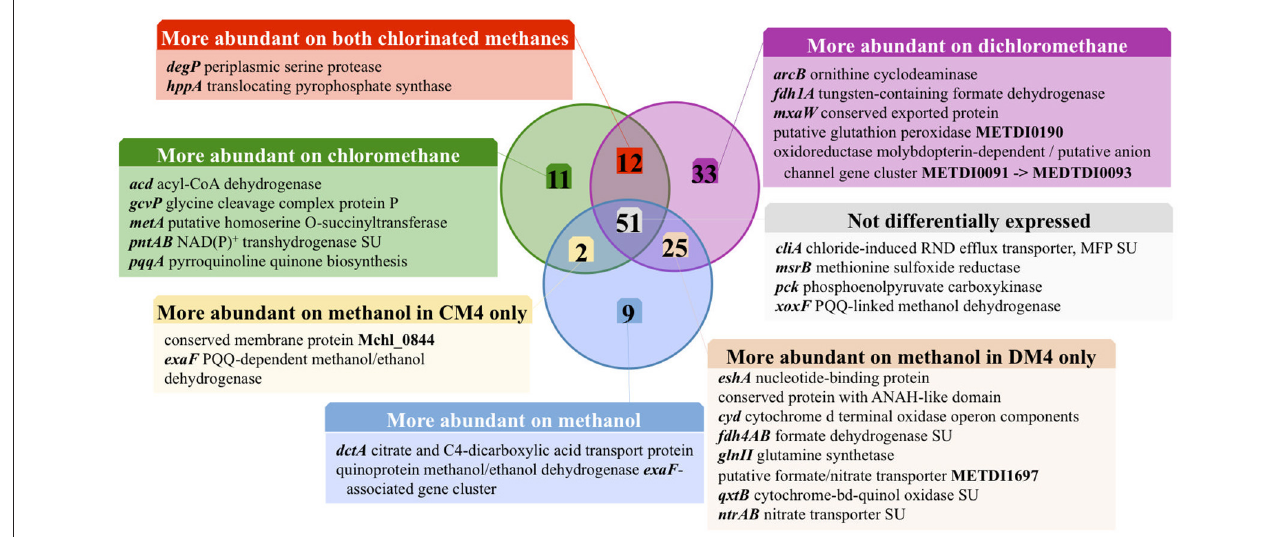
FIGURE 2 | Carbon source-dependent transcript abundance of common core genes in M. extorquens CM4 and DM4. Different categories were defined on the basis of the log 2 fold-change (log 2 fc) values of RNA-Seq reads for M. extorquens CM4 grown with CM (green circle) and for M. extorquens DM4 grown with DCM (purple circle) versus methanol (blue cercle). Complete gene names, log 2 fc values for each category are detailed in Table S4.